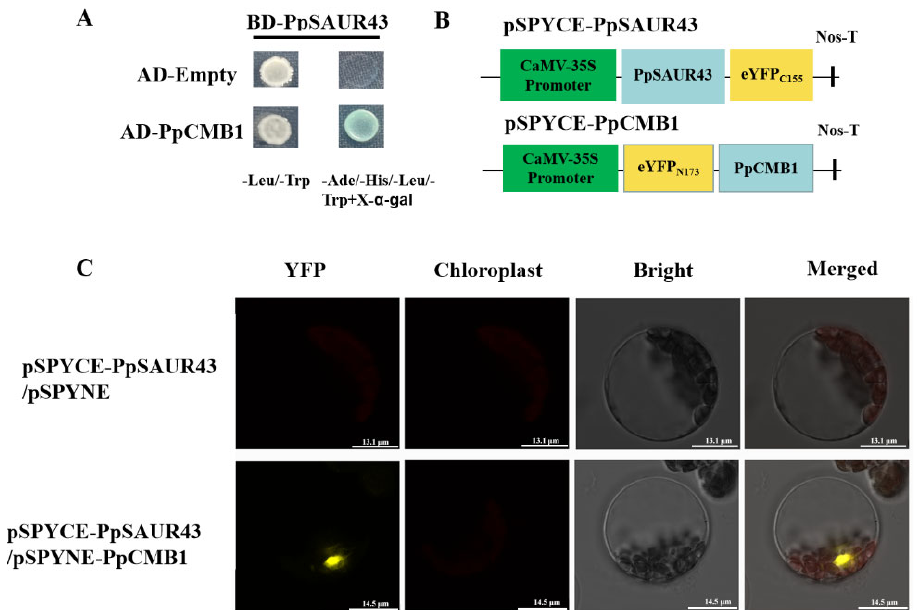
Figure 5. Analysis of the interaction between PpSAUR43 and PpCMB1. ( A ) The Y2H assay confirmed the interaction between PpSAUR43 and PpCMB1 in yeast. ( B ) Schematic diagrams of the vectors used in the BIFC assay. ( C ) The BIFC assay confirmed the interaction between PpSAUR43 and PpCMB1 in Arabidopsis protoplasts.